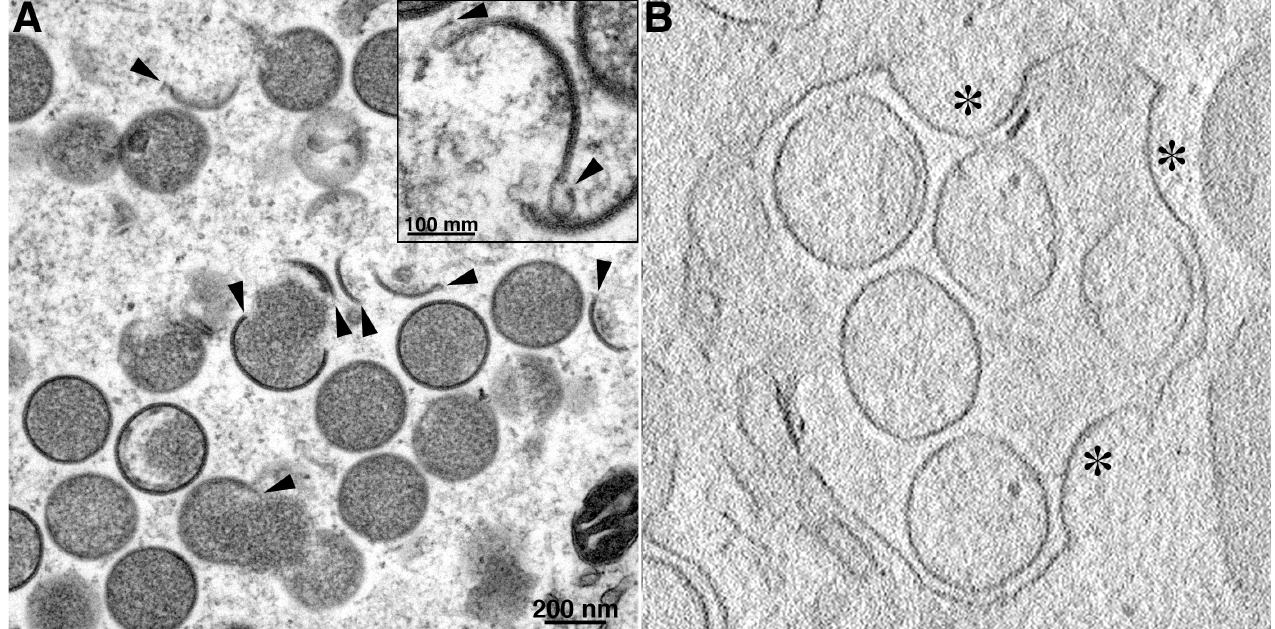
Fig 1. Transmission electron microscopic images of viral structures formed during infection with wild-type VACV and a VMAP (viral membrane assembly protein) mutant. (A) Infection with wild-type VACV. A cluster of crescents with free ends, some of which are marked with arrowheads, and circular IVs are shown. The higher magnification in the inset reveals the spicule layer on the convex surface of crescents as well as characteristic uncoated curls at their ends. (B) Infection with the VMAP A30.5 deletion mutant. This image is from an electron tomography tilt series that shows continuity between curved viral crescent structures, marked by asterisks, and the smooth ER membrane. The crescents appear to be budding into the expanded lumen, which is filled with IV- like structures. Images kindly provided by A . Weisberg .